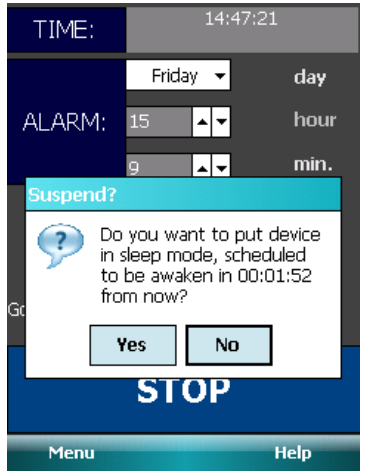
Figure 8. wakeNsmile application